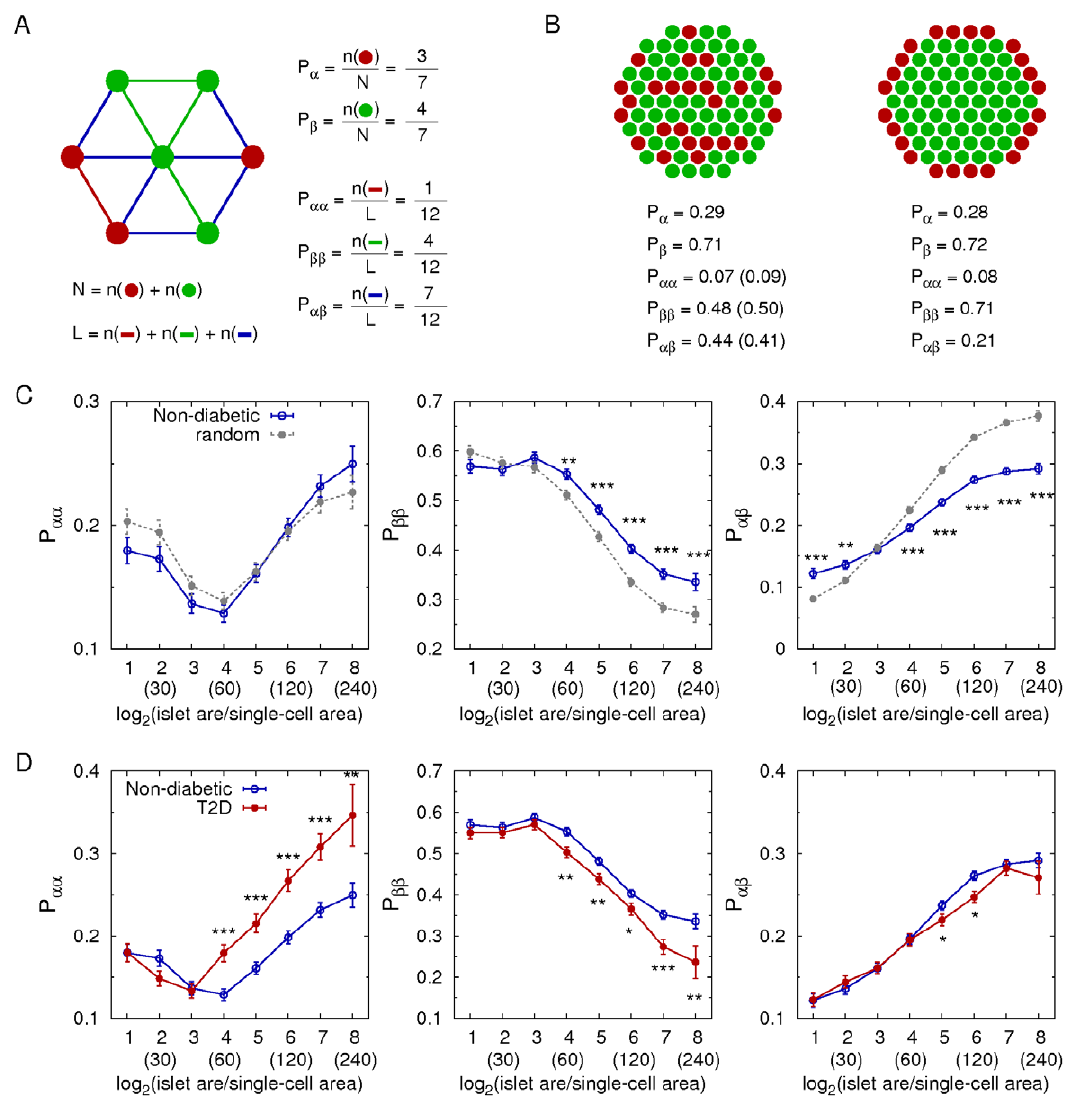
Figure 7. Changes of islet architecture in T2D. A: A simple example to calculate cellular compositions and probabilities of contact between cell types in an islet consisting of 3 alpha- (red) and 4 beta- (green) cells. Lines represent contacts between neighboring cells. B: two examples of distinctive architectures: random mixture of cells (left) and a regular structure (right) where cellular composition is the same (alpha:beta=3:7). The numbers in parentheses are the probabilities of contact between cell types in the random cell mixture, which are theoretically estimated as ( P aa = P a 6 P a , P bb = P b 6 P b , P ab = P a 6 P b + P b 6 P a ). C: Probabilities of alpha-alpha, beta-beta, and alpha-beta cell contacts in non-diabetic subjects (blue; 6886 islets with n=14). Those were compared with the theoretical estimation for random mixtures of cells (gray) where cellular compositions were the same with the individual islets in non-diabetic subjects (mean 6 SEM). D: Comparison between non-diabetic (blue) and T2D (red; 5359 islets with n=12) subjects. Note that scattered single endocrine cells are excluded in the calculation because contacting cells does not exist for them. The numbers in parentheses represent effective islet diameters ( m m) corresponding to the given logarithmic dimensionless islet areas. Student’s t -test compared the results between non-diabetic and T2D subjects at each size bin with *P , 0.05, **P , 0.001, and ***P ,